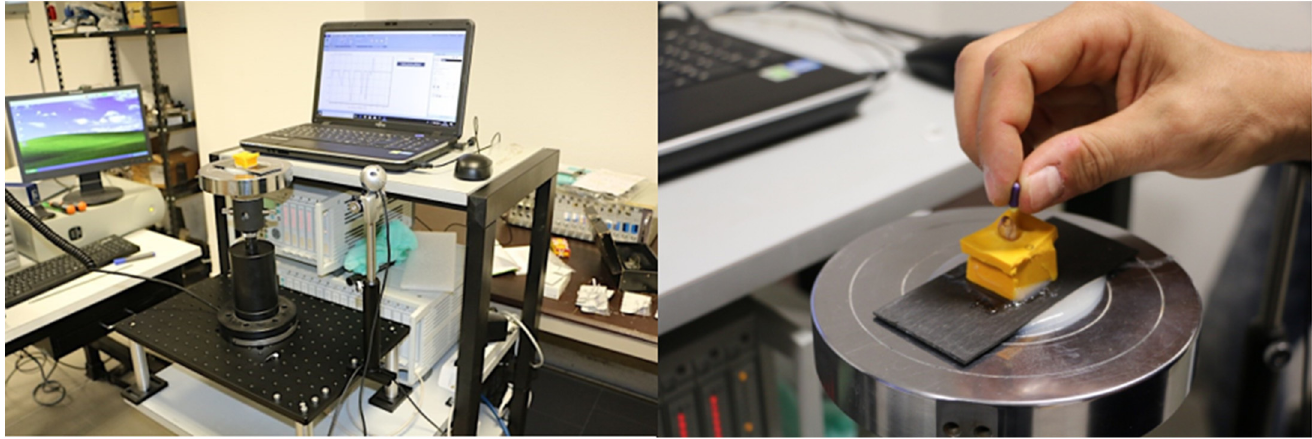
Figure 2. The testing machine. Full instrument equipment ( left view) and K ‐ file positioning ( right view).